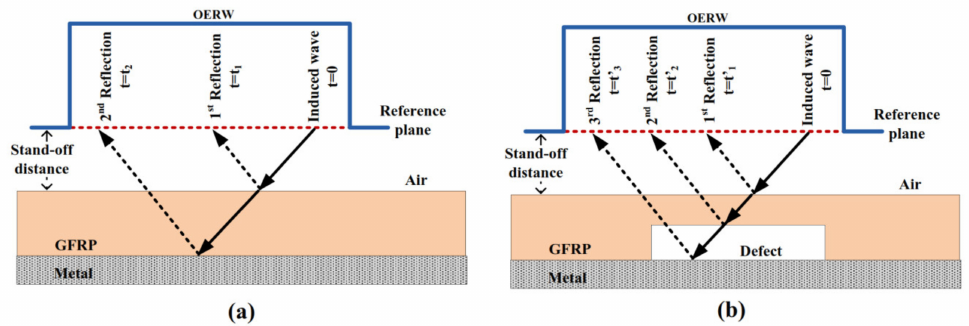
Figure 12. Cross-section diagram of the scanning arrangement using an open-ended rectangular waveguide in case of ( a ) defect-free and ( b ) defect